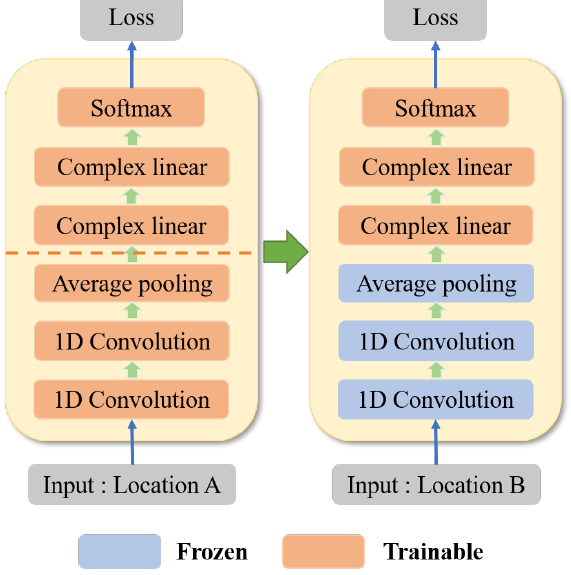
Figure 8. Architecture of transfer learning network.